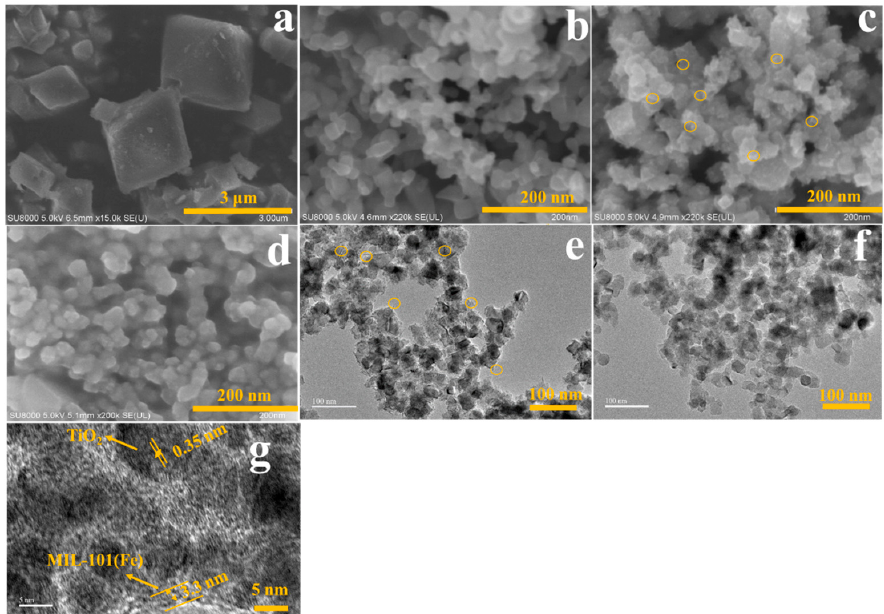
Figure 2. SEM images of MIL ‐ 101(Fe) ( a ) and TiO 2 ( b ); SEM images of the MOF precursor/TiO 2 ( c ) and MIL ‐ 101(Fe)/TiO 2 ( d ); ( e ) TEM images of MOF precursor/TiO 2 and MIL ‐ 101(Fe)/TiO 2 ( f ); ( g ) High ‐ resolution TEM image of MIL ‐ 101(Fe)/TiO 2 .